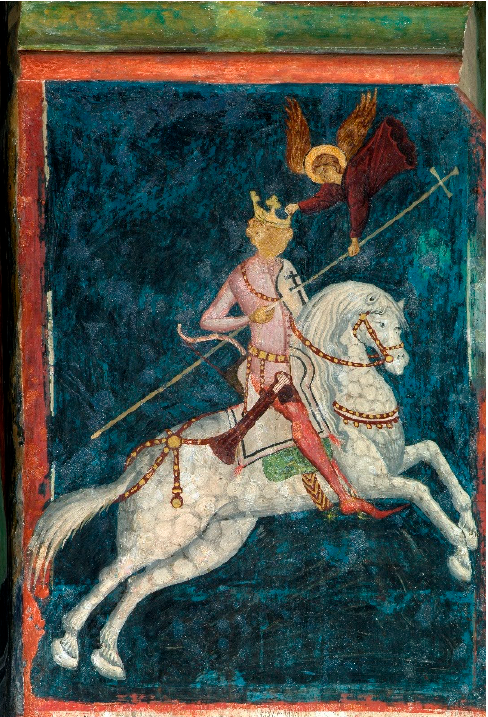
Figure 3 . Ladislaus Jagie łł o as a rider mounted on a galloping steed, frescoes, 1418, Lublin, royal Figure 3. Ladislaus Jagiełło as a rider mounted on a galloping steed, frescoes, 1418, Lublin,